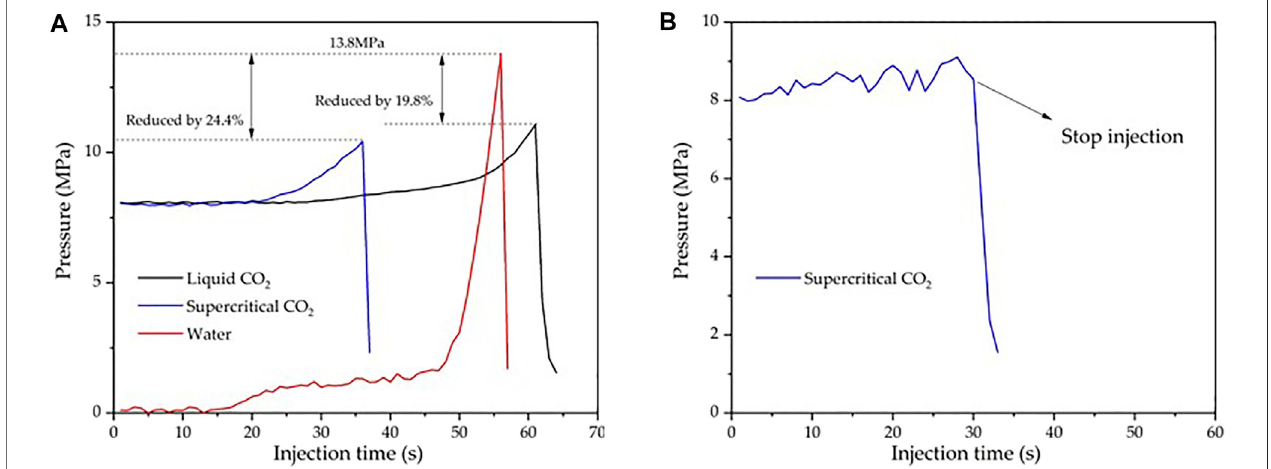
FIGURE 3 | The pressure curves: (A) Pressure cruves with an obvious breakdown point of water, liquid CO 2 and supercritical CO 2 ; (B) Pressure cruve without breakdown point.